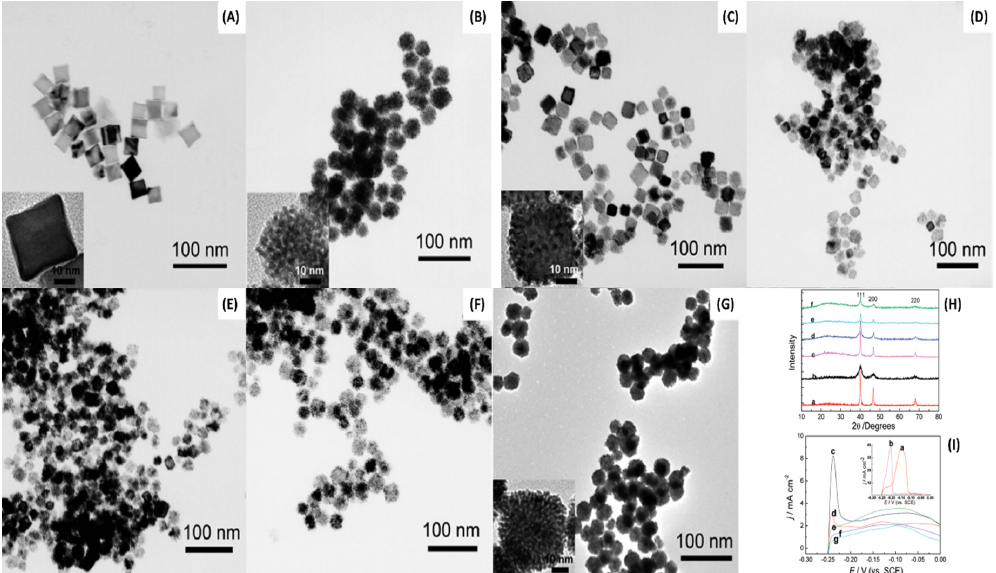
Figure 9. TEM images, ( A – G ) in order are pure Pd, Pt, nanostructures with PdCl 2 /K 2 PtCl 4 molar ratio of 3:1, 2:1, 1:1, 1:2, and 1:3; ( H ) shows the PXRD data, and CV results are shown in ( I ), these CVs were calculated using modified GCE in the potential range of − 0.25 to 0 V in 0.5 M H 2 SO 4 solution with a scan rate of 50 mVs − 1 , only positive scan data had been shown for clarity. Adapted with permission from the American Chemical Society. Copyright 2010 American Chemical Society. ( A ) Schematic representation for the formation of Pd core-Au shell NPs; ( B ) concentration vs. time (min) dependence for Pd 2+ (1, 3), and Au 3+ (2, 4).